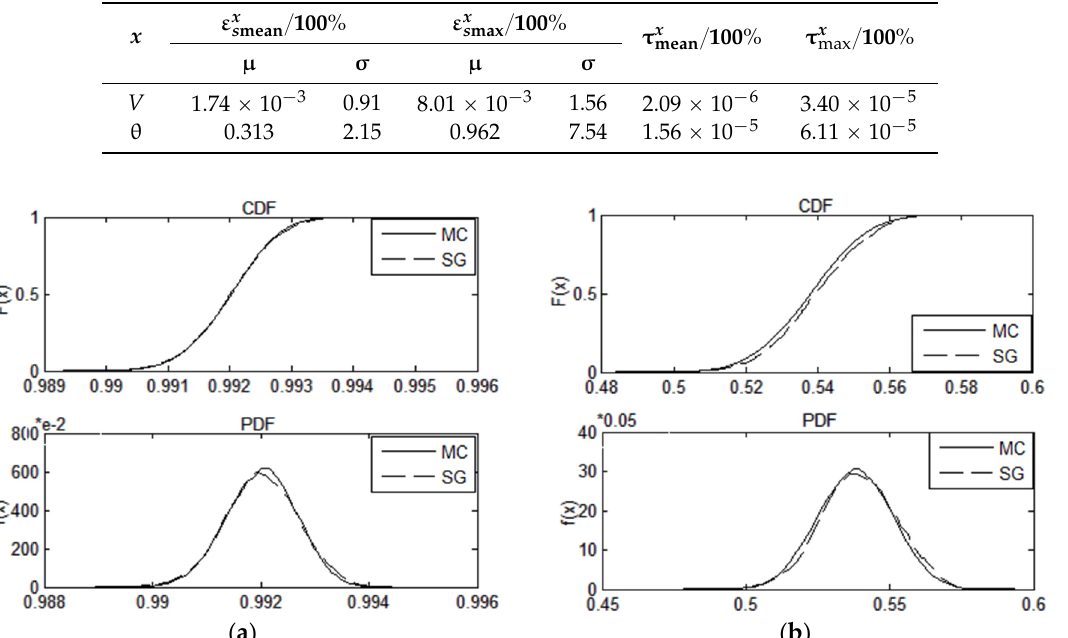
V (p.u.); ( b )  (rad). 49 26